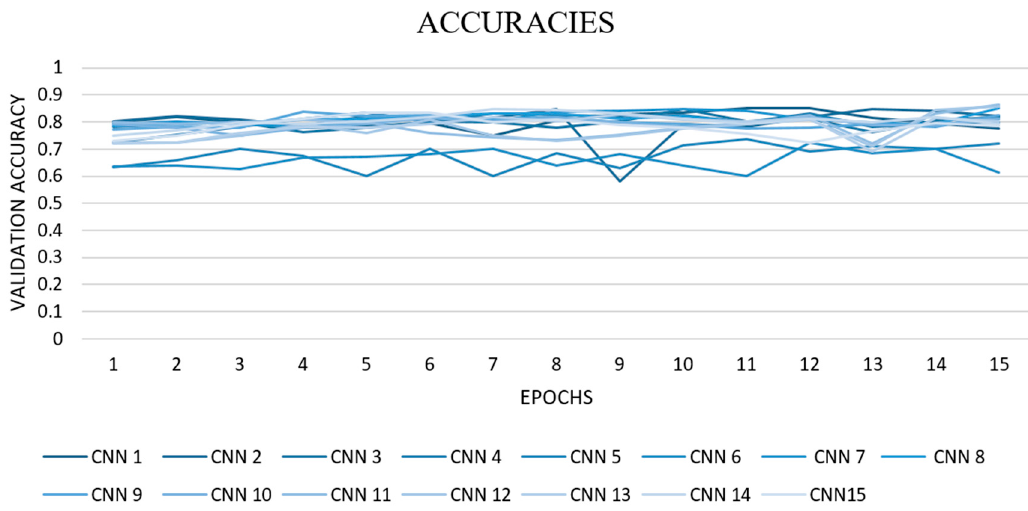
Figure 6. Training curve of validation accuracy for each CNN architecture per epoch.